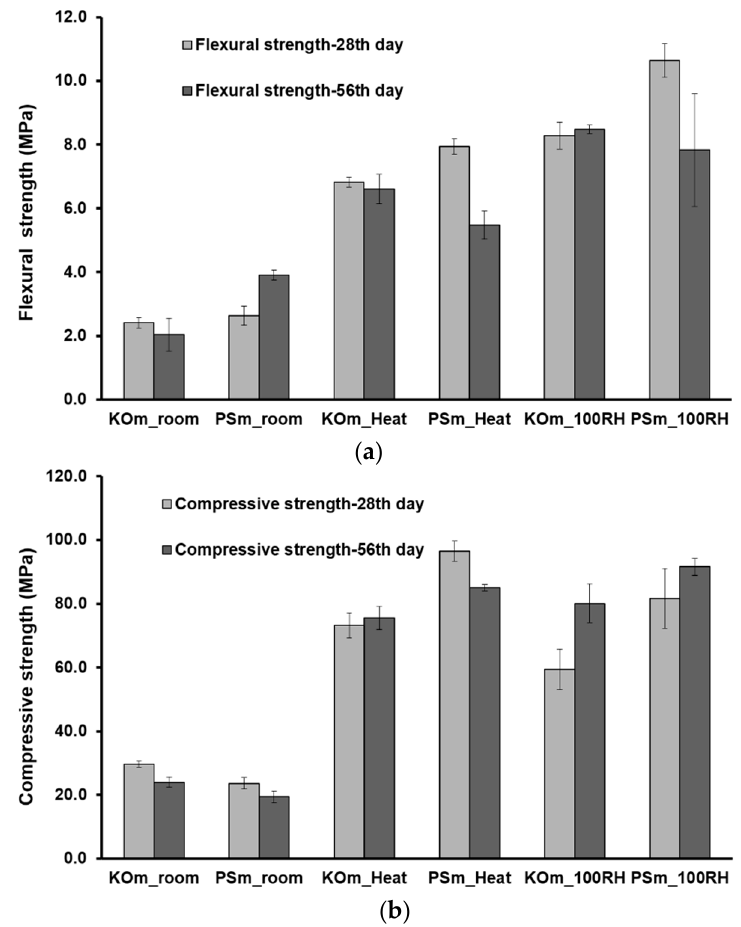
Figure 10. Flexural ( a ) and compressive strength of mortars ( b ) at different ages (28 and 56 days). Average results and corresponding standard deviations are provided.